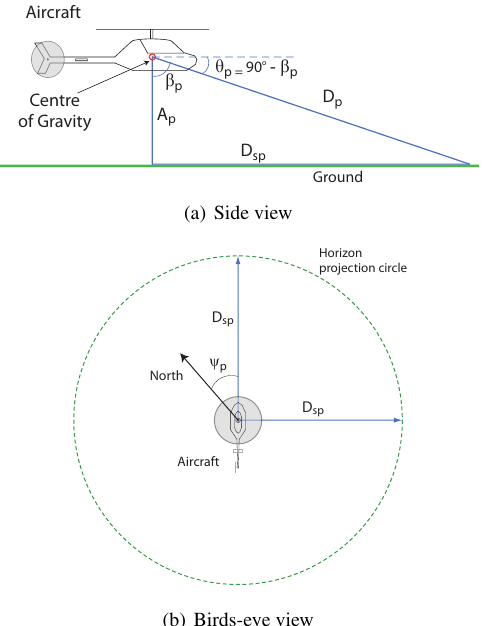
Figure 1: Side and birds-eye views of the theoretical horizon on the Earth’s